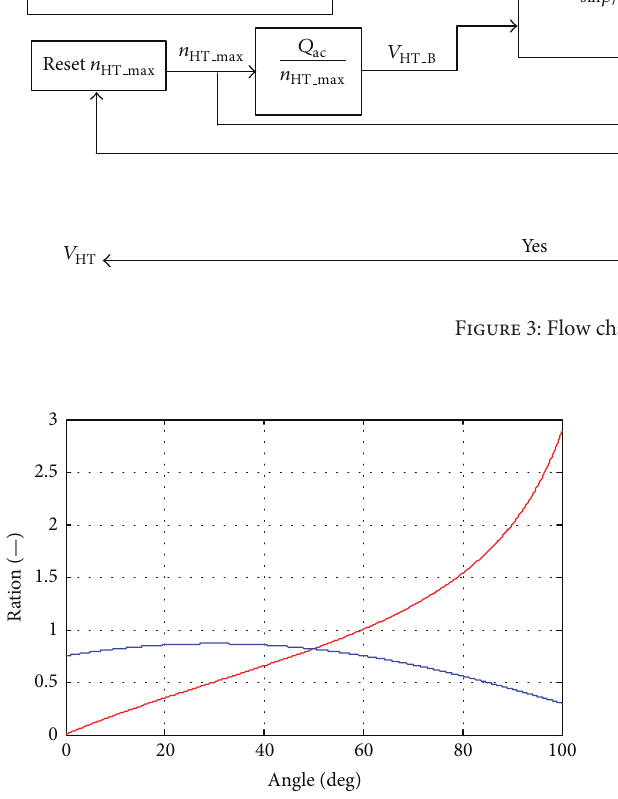
Figure4:Curvesof 𝑉 values of 𝛿 .